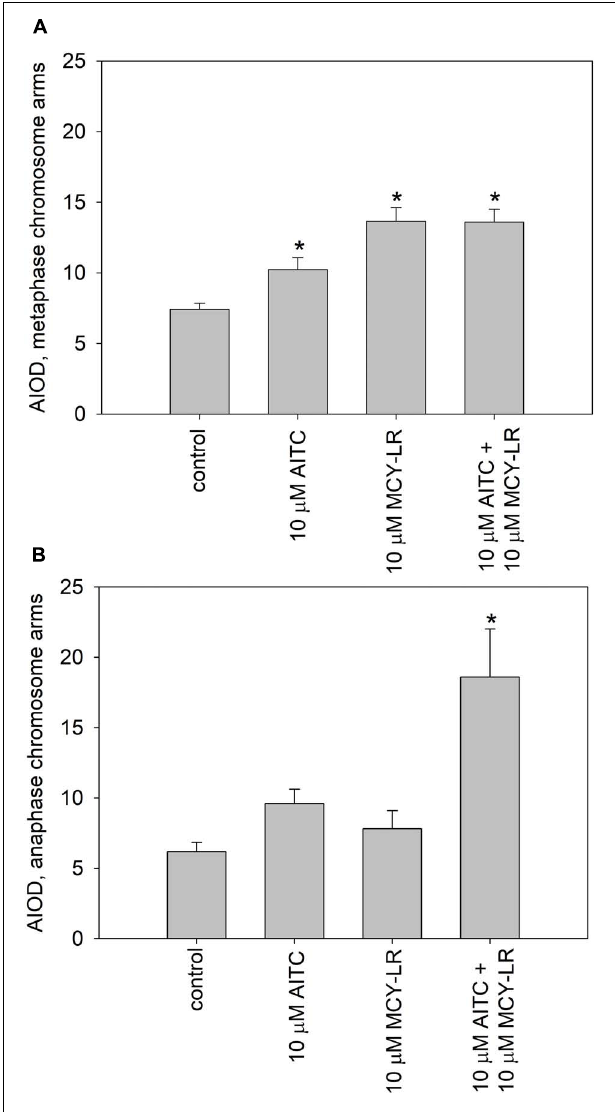
FIGURE 7 | Effects of high AITC and MCY-LR concentrations on histone H3 Ser10 phosphorylation in metaphase (A) and anaphase (B) cells. ∗ Significant differences of treatments to controls ( P < 0.05), n ≥